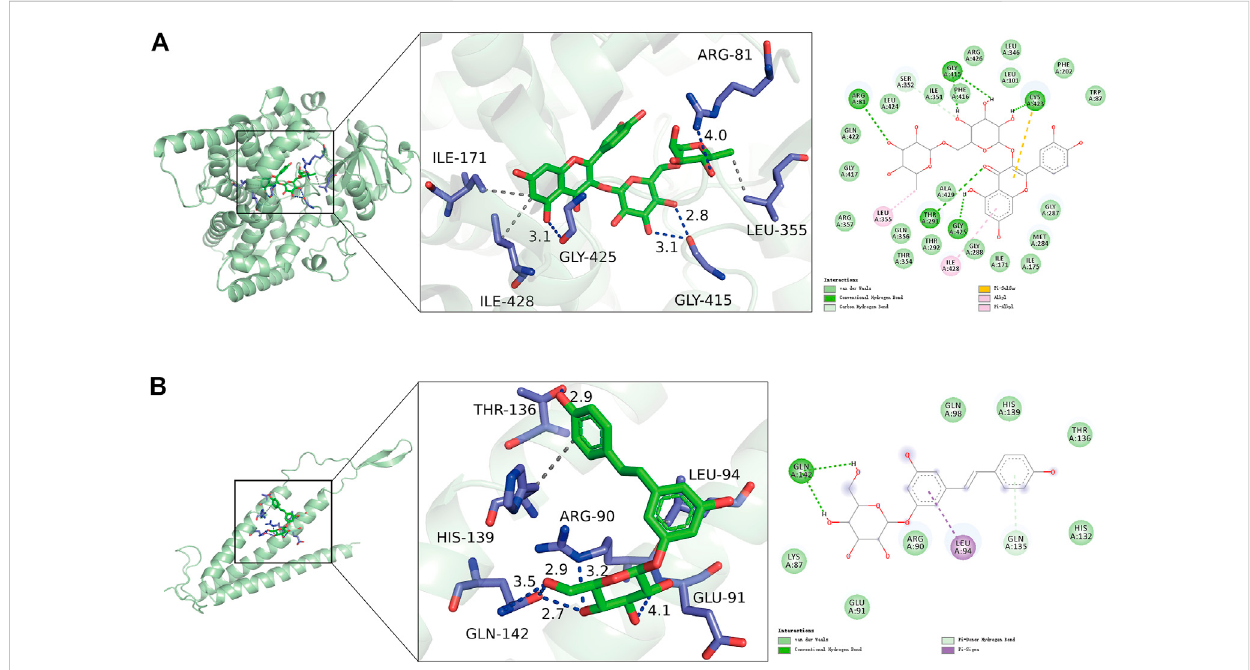
FIGURE 9 Molecular docking results ofsignature geneswith related natural compounds. (A) Optimalbinding model for Rutin to FDX1 with aminimum binding free energy of -9.3 kcal/mol. (B) Optimal binding model for Polydatin to SLC31A1 with a minimum binding free energy of -5.5